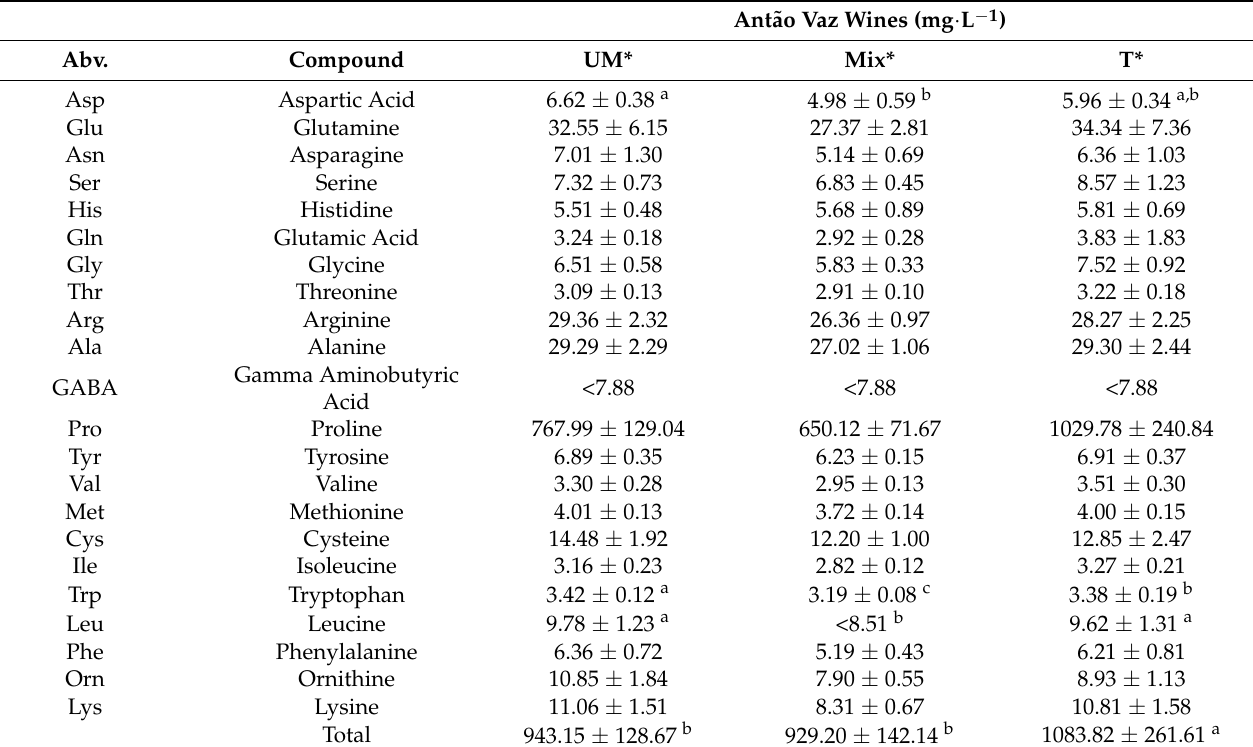
Table 2. Average concentrations of the AA obtained from the analysis of all Ant ã o Vaz wines. Each value represents the mean ± standard error of the mean for the samples analysed, UM*, Mix* and T*. (Different letters in row mean significant differences at p <